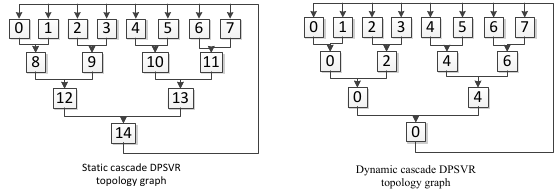
Fig. 3. Static cascade DPSVR and Dynamic cascade DPSVR topology